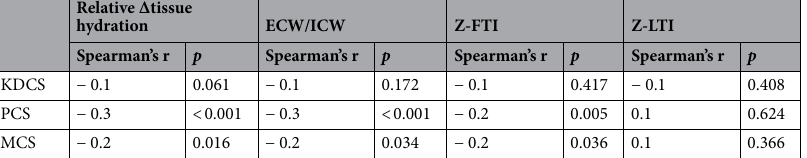
Table 3. Correlation of body composition parameters with HRQOL components. HRQOL health related quality of life, ECW extracellular water, ICW intracellular water, Z-FTI Z-score of fat tissue index, Z-LTI Z-score of lean tissue index, CI confidence interval, KDCS kidney disease component summary, PCS physical component summary, MCS mental component